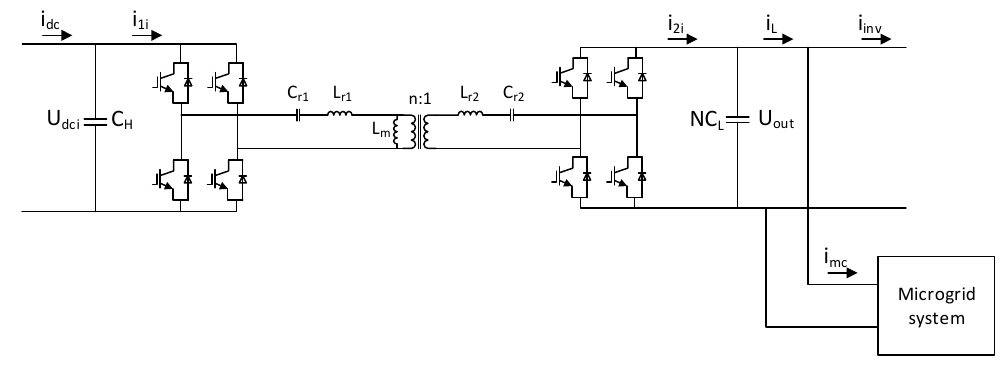
Figure 4. The submodule topology of the CLLC resonant converter.